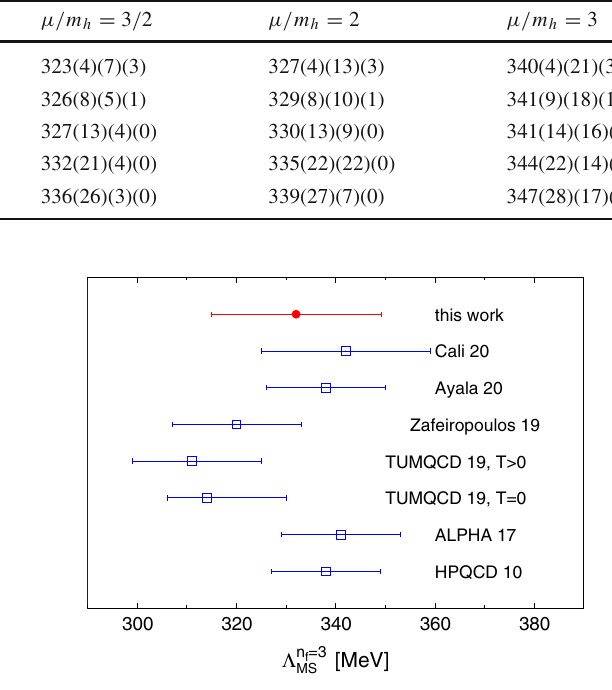
Fig. 5 Comparisonofthe Λ -parameterinthree-flavorQCDfromRefs. [4,23–27] (from left to right) to the present determination. The result of Ref. [22] are not shown as these are superseded by Ref. [23] = 3 and the band MS correlator [27]. This comparison is shown Fig. 5. We see that our result is consistent with other lattice n f = 3 = 331 . 4 MS